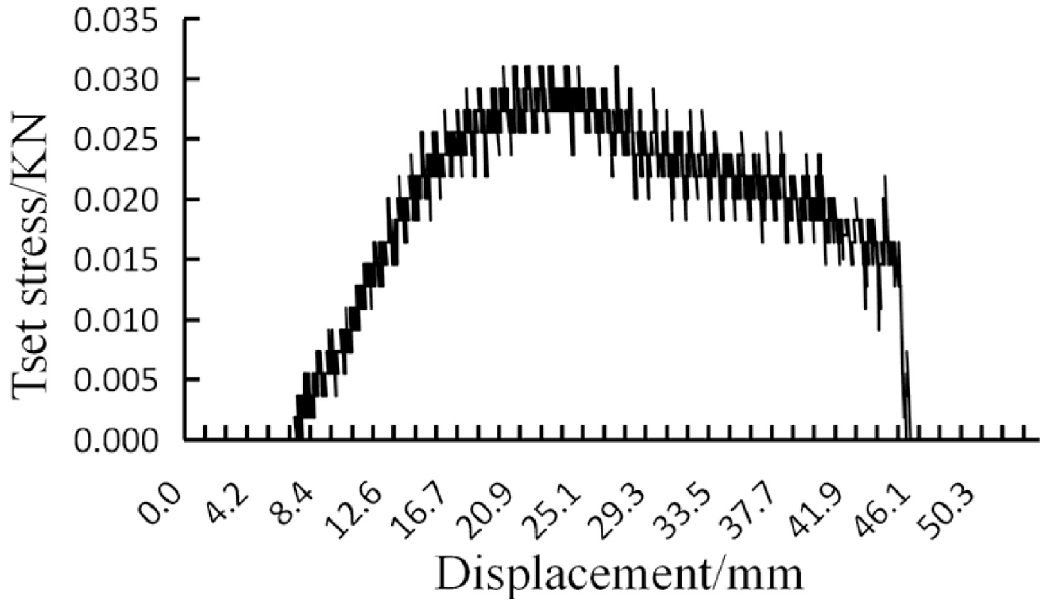
Fig 6. Stress-displacement curve.